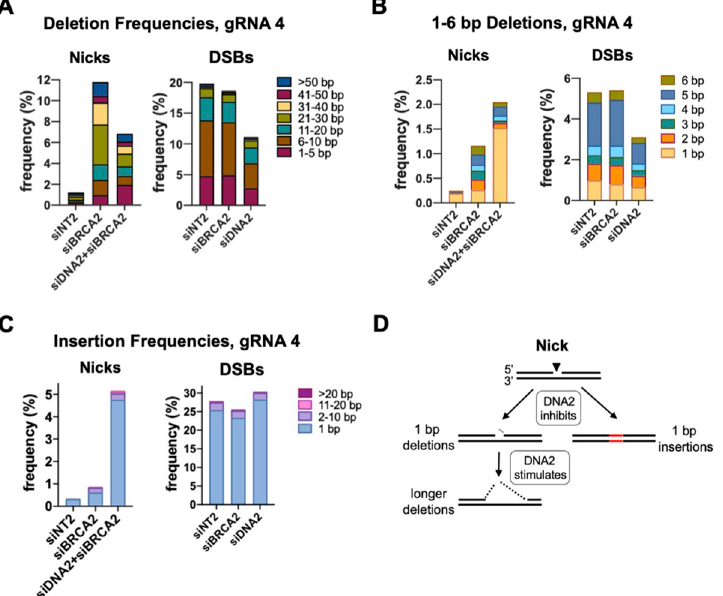
Fig 4. DNA2 inhibits 1 bp indels but promotes longer deletions at nicks targeted by gRNA 4. (A) Effects of depletion of BRCA2 and/or DNA2 on frequencies of deletions of indicated lengths at nicks or DSBs targeted by gRNA 4 to the CD44 gene in U2OS cells, determined by amplicon sequencing. (B) Effects of depletion of BRCA2 and/or DNA2 on frequencies of 1–6 bp deletions at nicks or DSBs targeted by gRNA 4 to the CD44 gene in U2OS cells. (C) Effects of depletion of BRCA2 and/or DNA2 on frequencies of insertions of indicated lengths at nicks or DSBs targeted by gRNA 4 to the CD44 gene in U2OS cells. (D) Diagram of regulation of deletions and insertions by DNA2. Inhibition by REV3 and DNA2 indicated by lines, with relative lengths reflecting relative magnitudes of inhibition. Resected DNA is indicated by dashes. Replicating DNA indicated by dashed black arrows; insertion by red